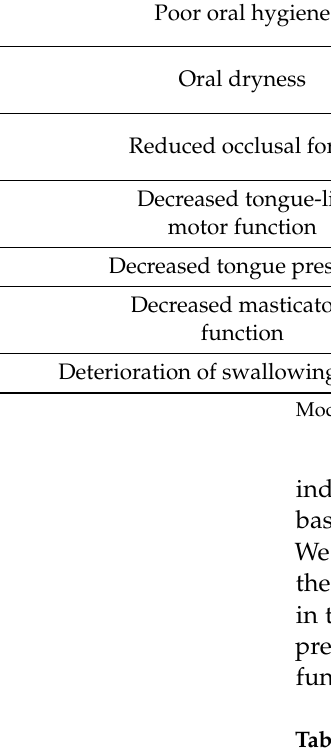
Table 6. Association between sarcopenia and oral